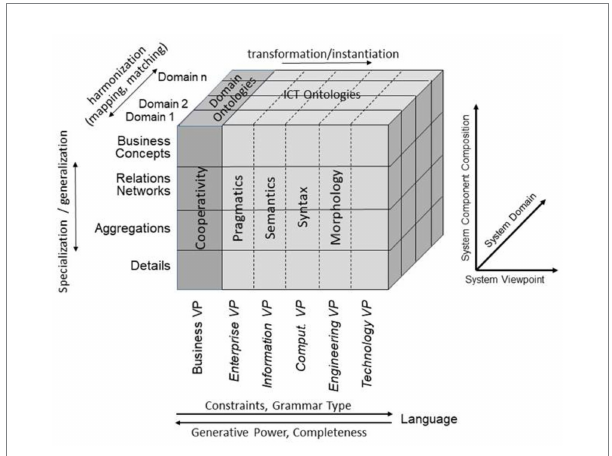
FIGURE 1 Transformed health and social care ecosystem according to ISO 23903 in a representational